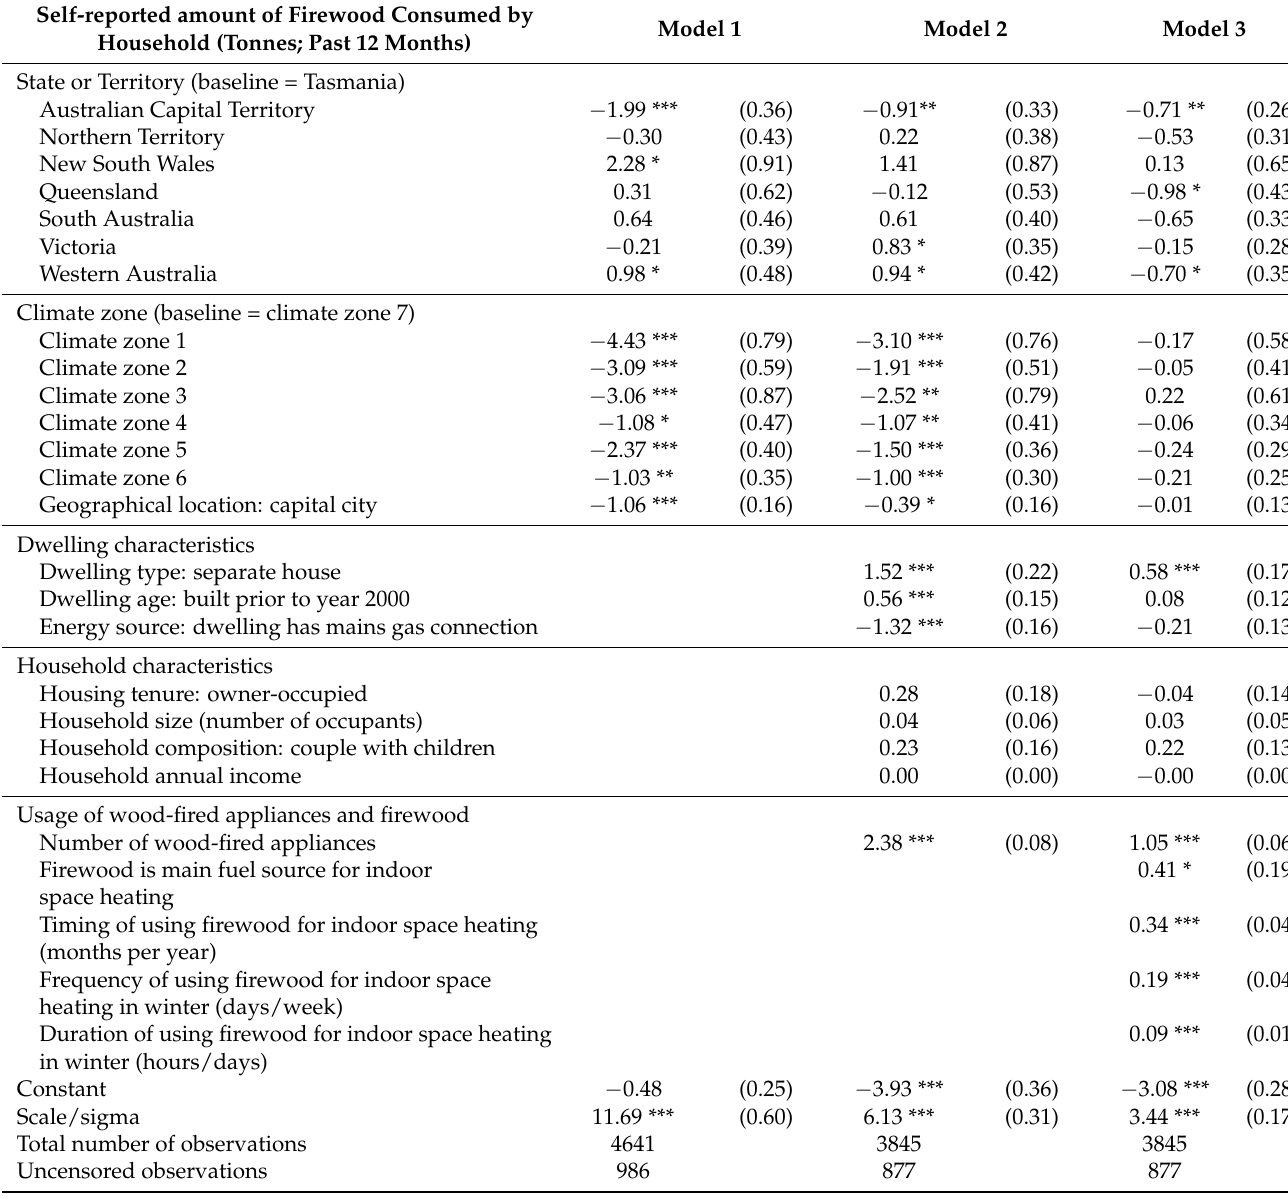
Table 5. Results of the Tobit models to investigate the key determinants of the total amount of firewood consumed per household each year in